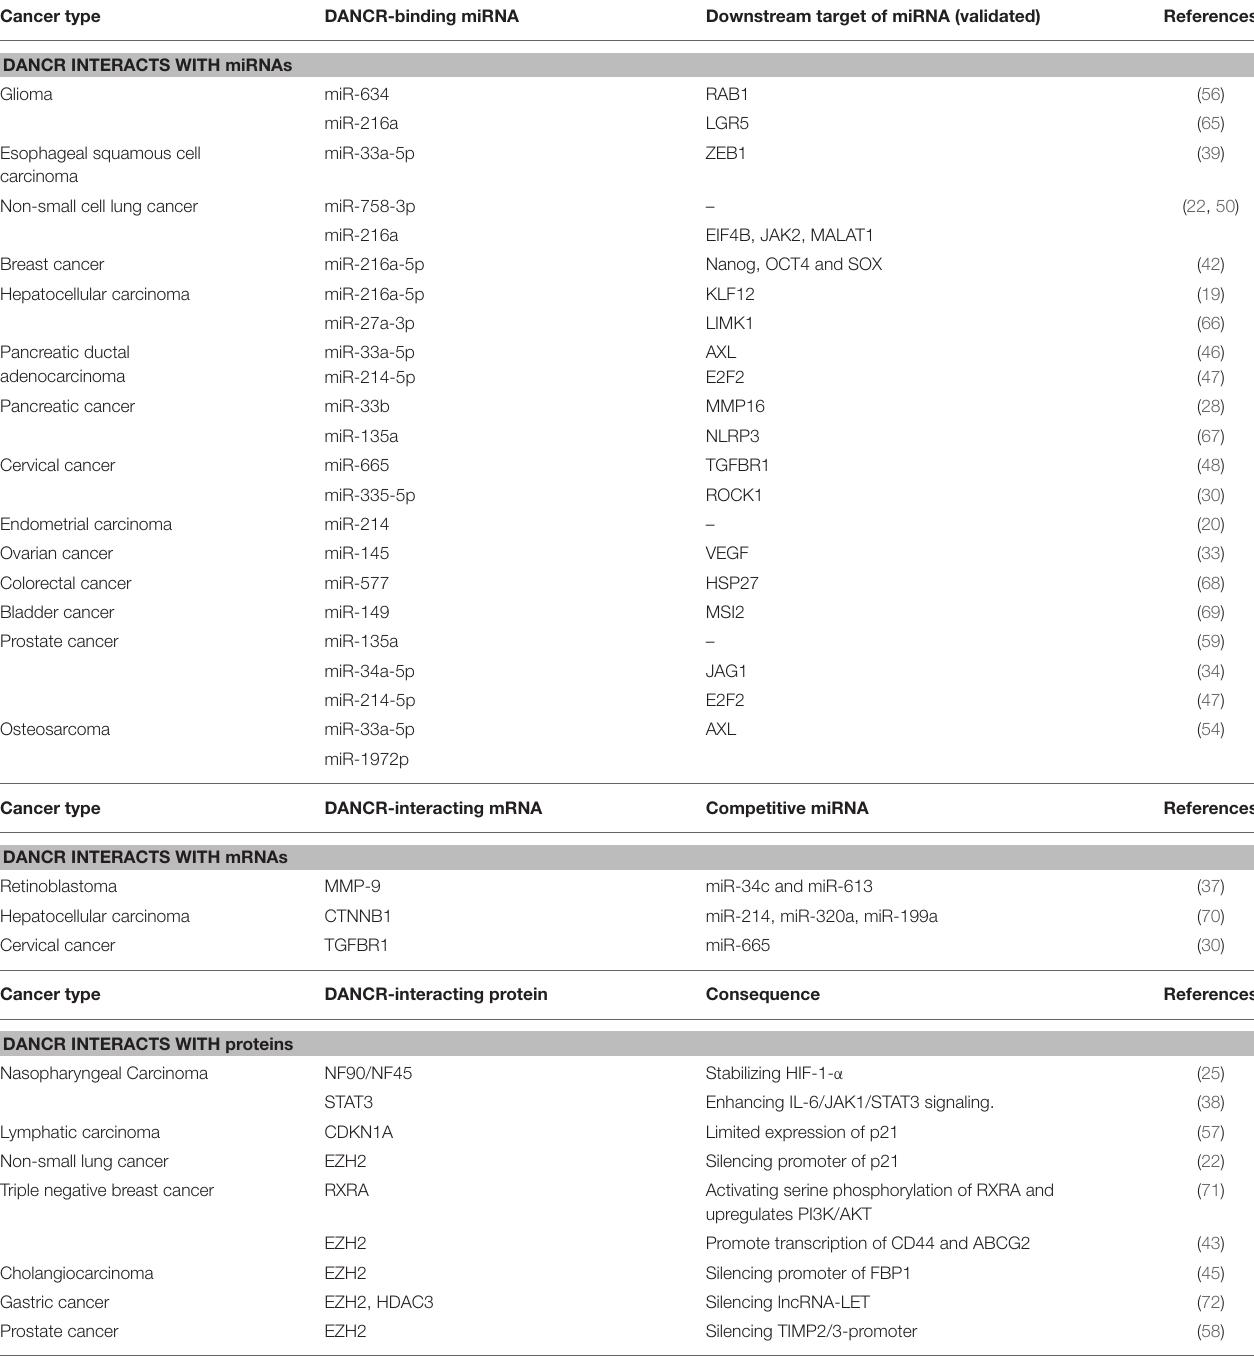
TABLE 2 | The putative molecular mechanisms of